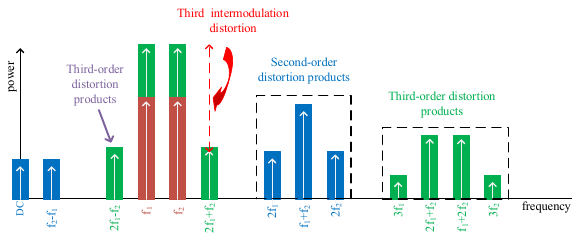
Figure 2. Third-order intermodulation distortion and